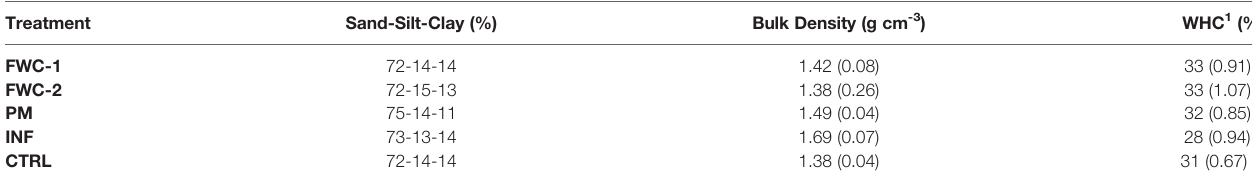
TABLE 6 | Physical properties of the soils – soil texture (sand-silt-clay), mean bulk density, and water holding capacity (WHC) – with respect to amendment treatment (food waste composts FWC-1 and FWC-2), poultry manure (PM), inorganic nitrogen fertilizer (INF), and control (CTRL).